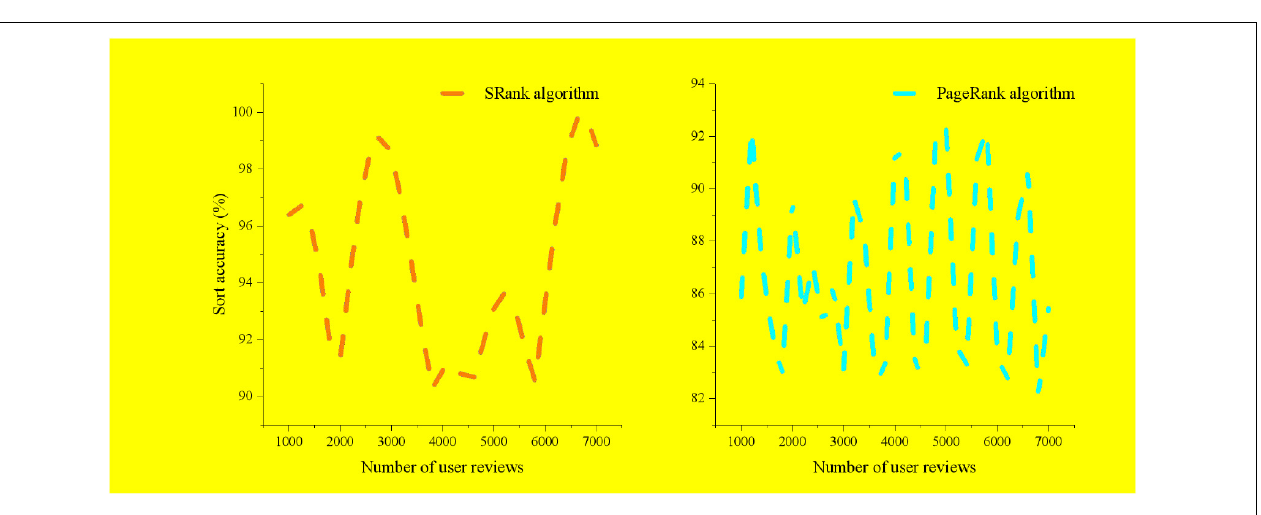
FIGURE 3 | Comparison of real-time ranking between AR algorithm and traditional PR algorithm.